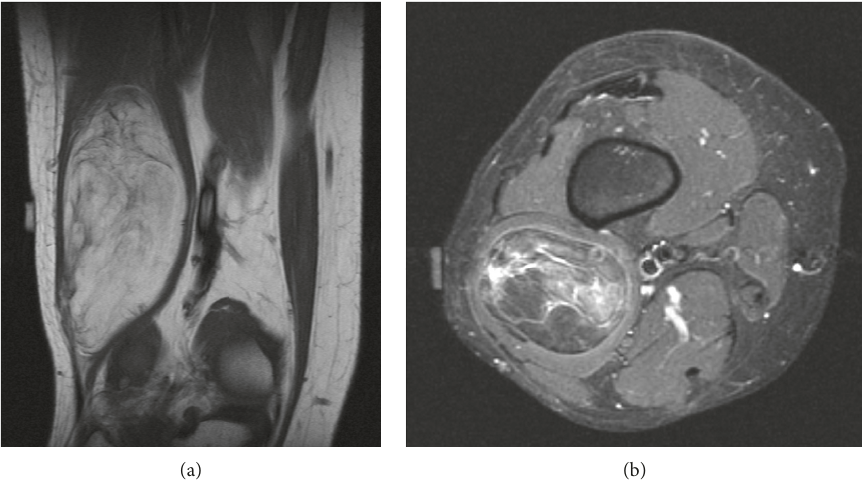
Figure 3: (a) Coronal T1 and (b) axial STIR MR images of the right thigh lipomatous tumor. Expert observers interpreted the lesion as heterogeneous, containing stranding, and having foci of high T2 signal. All four readers interpreted the tumor as ALT/WDL in addition to initial pathology interpreted as ALT/WDL. MDM2 amplification during FISH analysis confirmed benign lipoma on two separate occasions, illustrating the variability that can be seen within simple